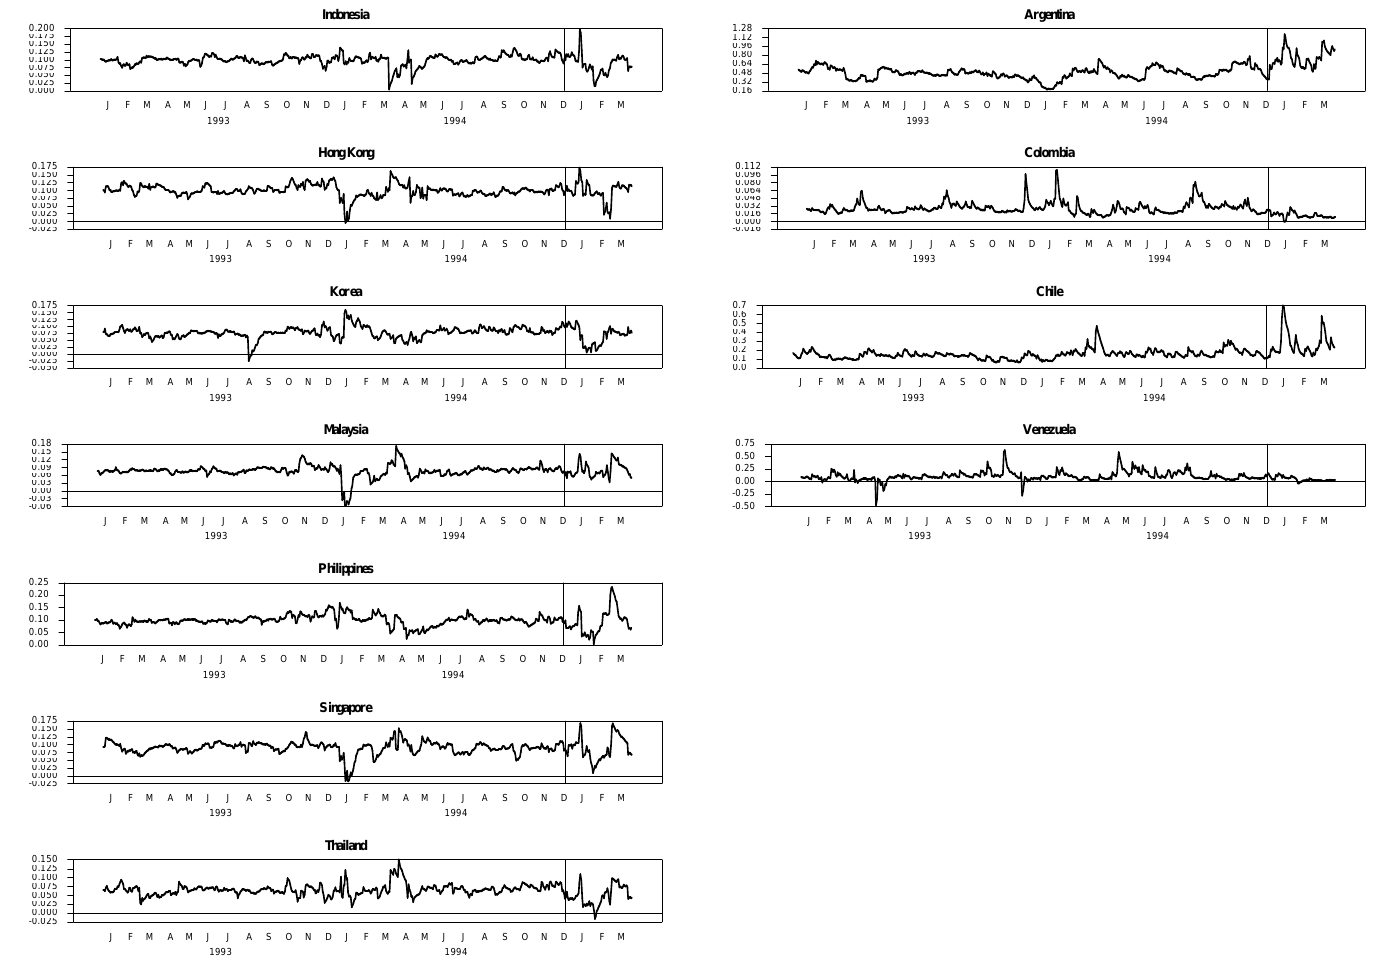
Figure 1. The dynamic correlation estimation for the Mexican “Tequila” crisis. The vertical continuous line represents the break date: 19 December